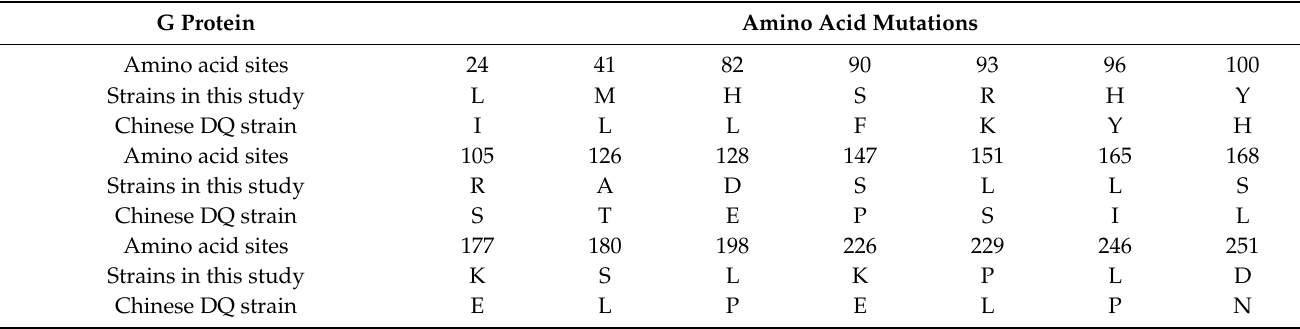
Table 4. Amino acid mutations of G protein sequences in this study compare with the sole Chinese subgroup III strain in